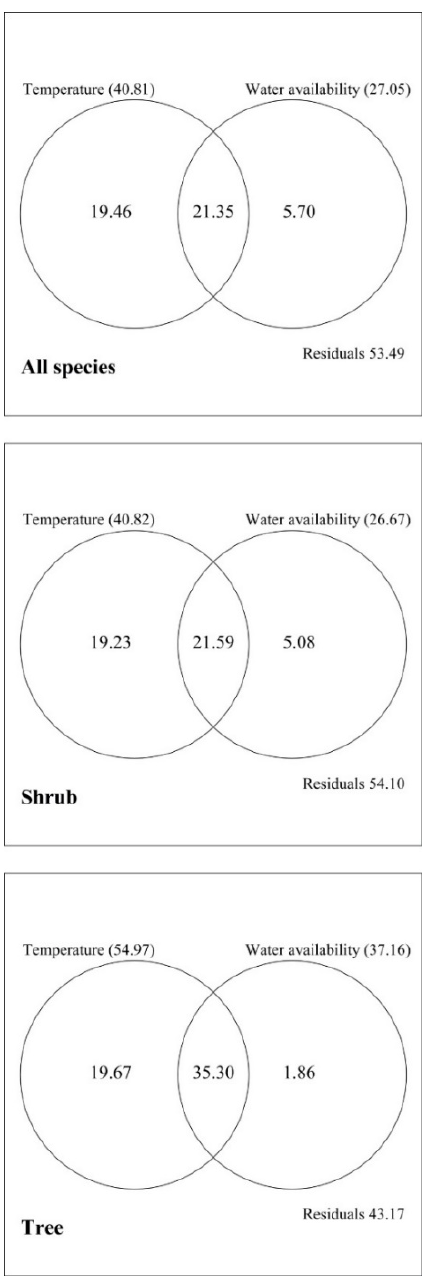
Figure 4. Partitioning of species richness into temperature (including mean annual temperature, temperature of the coldest month, temperature of the warmest month) and water availability (including mean annual precipitation, precipitation of the driest month and precipitation of the wettest month) for all species, and for shrubs and trees in Yunnan. Values represent adjusted R 2 coefficients of independent or shared effects by each variable. Total effect (including independent and shared effects) of each explanatory variable is shown in parentheses.